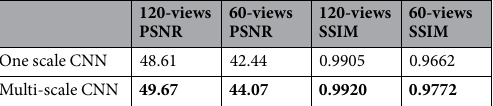
Table 6. Average values of PSNR and SSIM between proposed method and full-view FBP reconstruction for 256 * 256 CT images.